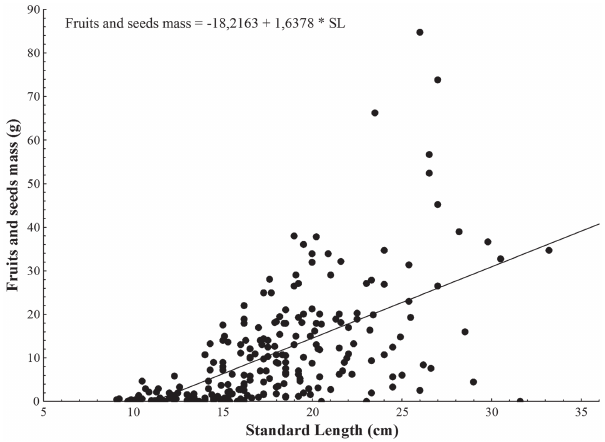
Fig. 3. Relationship between body size (cm) and the general consumption of fruits and seeds (g) by Lithodoras dorsalis at the Amazon River mouth, Brazil, from July 2010 to June 2011.